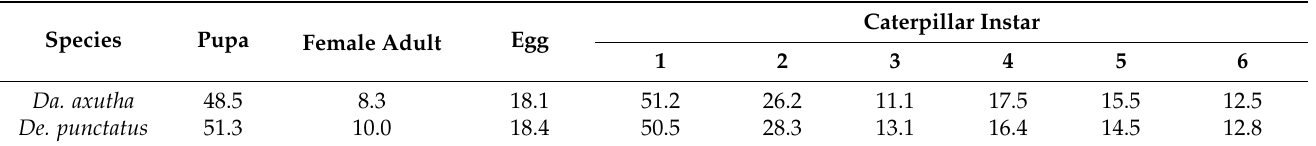
Table 4. Mortality percentage of each development stage in the laboratory.